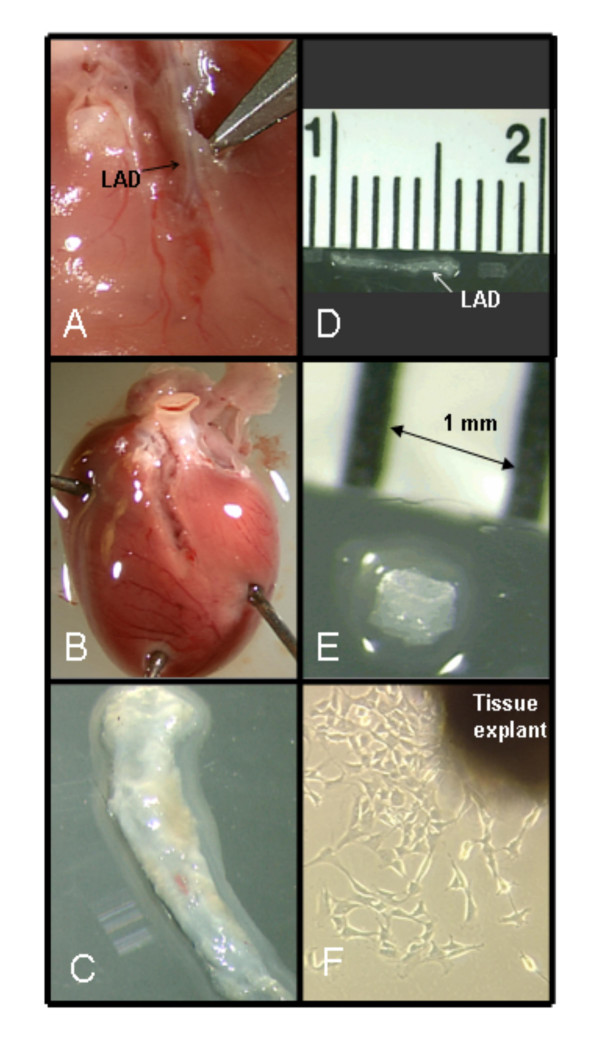
Removal of left anterior descending coronary artery (LAD) from SHR male rat. A) intact LAD, B) heart with LAD removed, C) isolated LAD, D) LAD length, E) LAD diameter, and F) fibroblasts migrating from LAD explant.